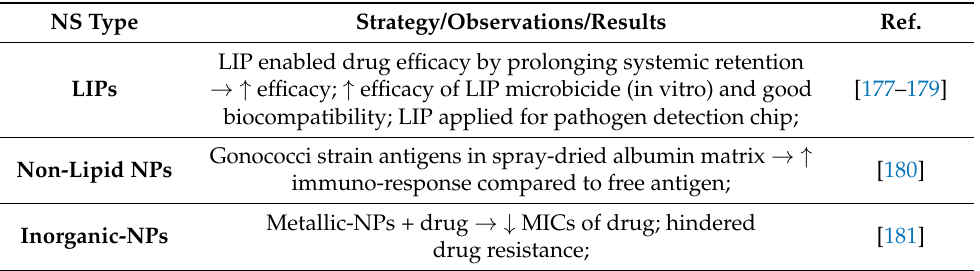
Table 8. Nanosystems for treatment of Ng